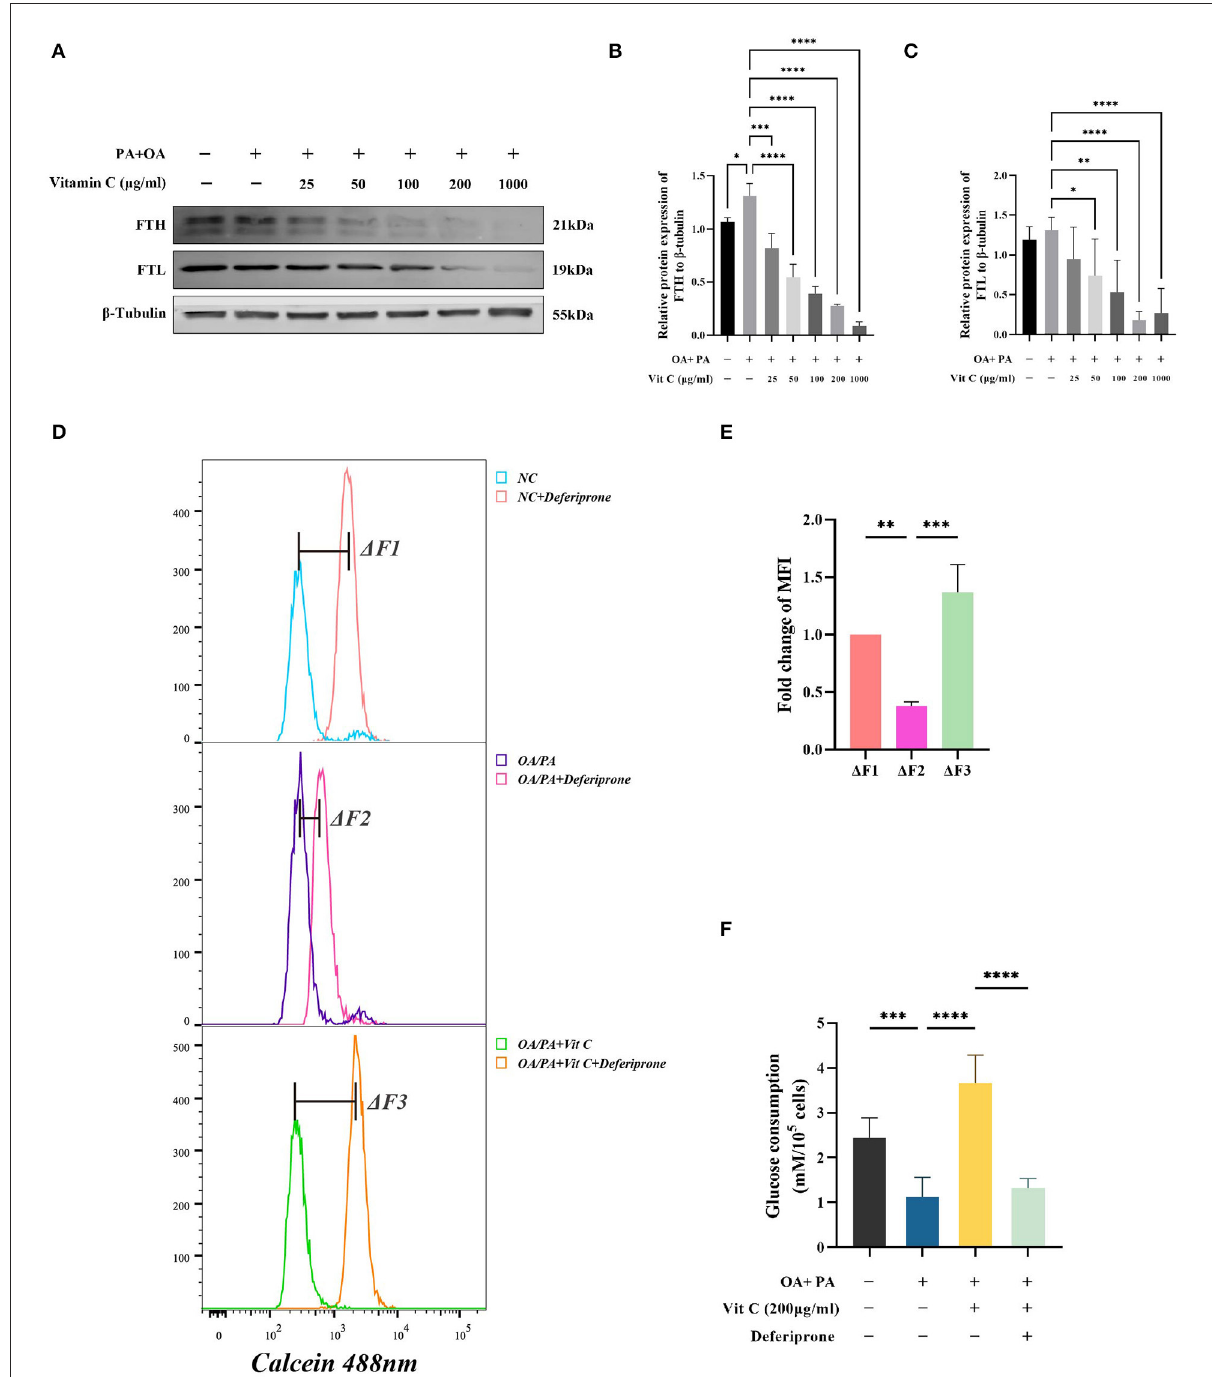
FIGURE5 Vitamin C effects on intracellular ferritin and LIP. (A–C) The protein levels of FTL and FTH in the HepG2 were determined by Western blot. (D) Vitamin C increased the labile iron pool in HepG2 cells, (E) Quantification of the levels of labile iron pool ( n = 3), and (F) Glucose concentration in the medium was measured after 24h treatment of HepG2 with 200 µ g/ml Vitamin C and 100 µ M deferiprone, respectively ( n = 6). Values were presented as means ± SEM. * p < 0.05, ** p < 0.01, *** p < 0.001, **** p <